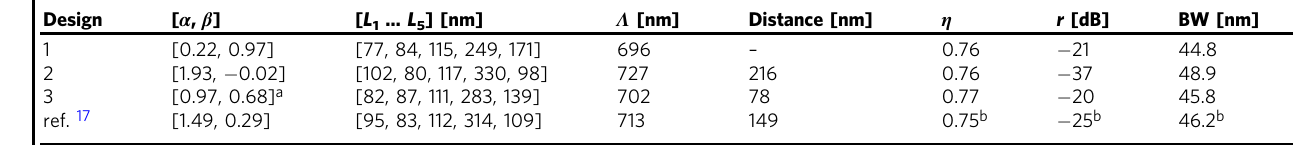
Table 1 Structural and performance parameters of selected grating designs as marked in Fig. 3